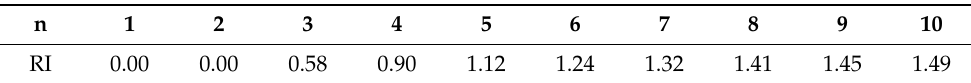
Table 2. Random index (RI) values for small problems